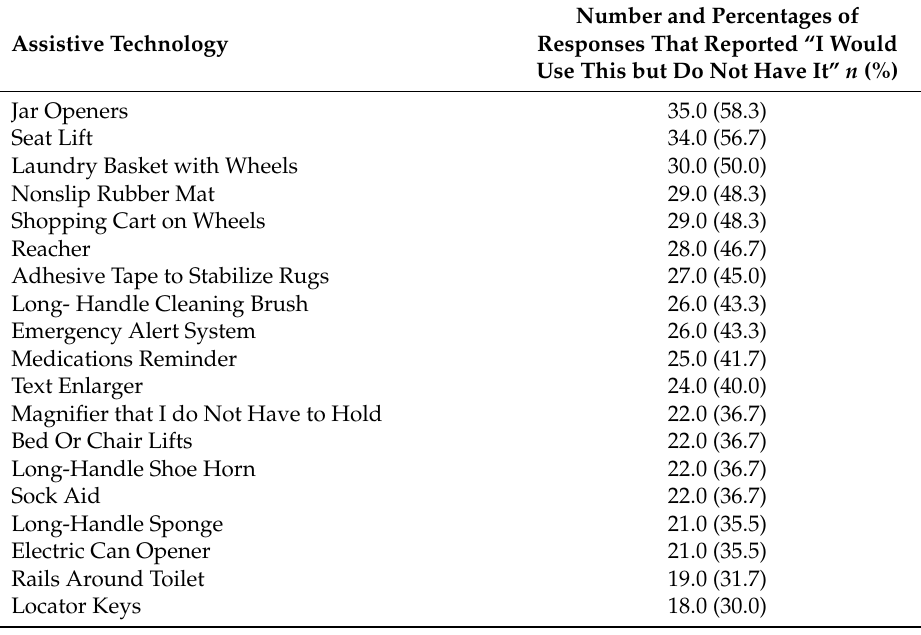
Table 2. Assistive technology devices identified as “I would use this but do not have